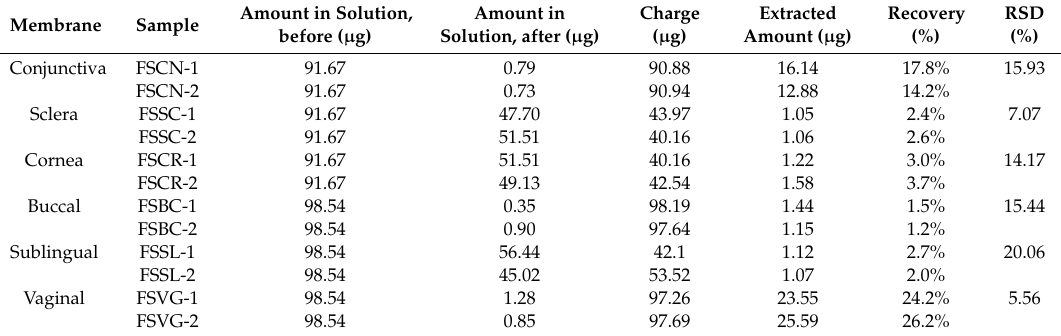
Table 4. Results of the carprofen recovery with phosphate bu ff ered saline (PBS) of the battery of fortified samples expressed by amount before and after penetration; extracted amount of tissues and final recovery % with relative standard derivation (RSD).